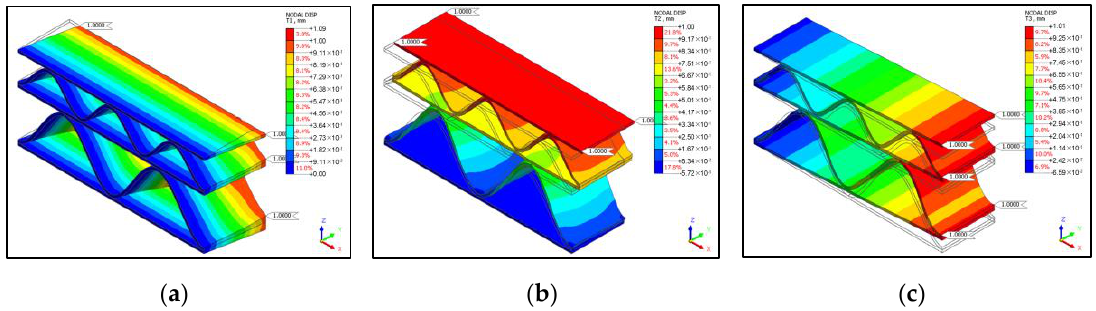
Figure 14. Directional reaction force for the unit cell of AB/F-DW corrugated paperboard, they should be list as: ( a ) xy -direction; ( b ) yz -direction; ( c ) zx -direction.